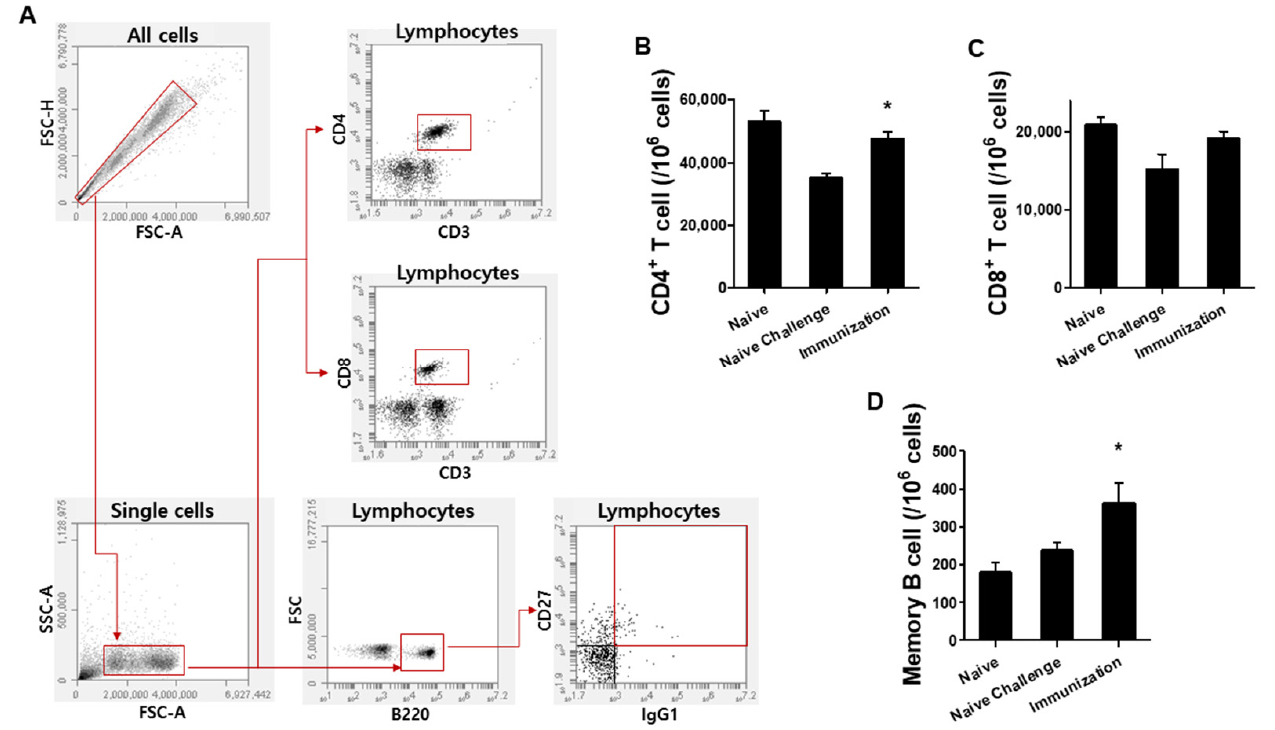
Figure 4. Immune cell responses. Gating strategy for CD4 + , CD8 + T cells and memory B cells ( A ). Numbers of CD4 + ( B ) and CD8 + ( C ) T cells and memory B cells ( D ) were analyzed by flow cytometry after P. berghei challenge infection. Higher numbers of CD4 + T cells ( B , * P < 0.05) and